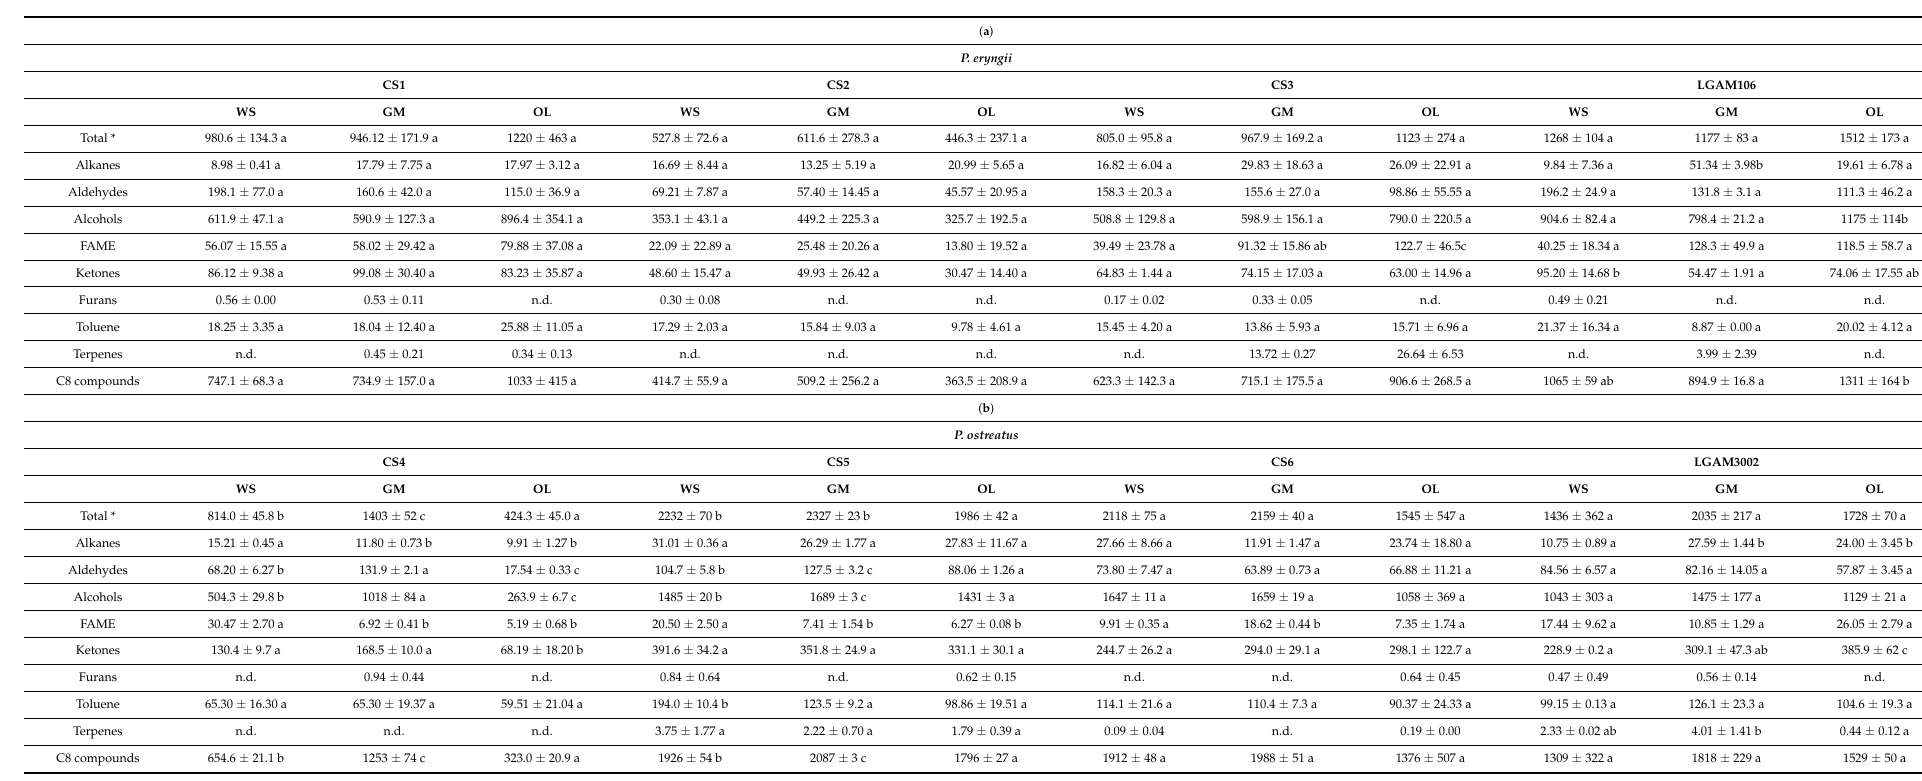
Table 2. ( a ) Classes of volatiles and toluene ( µ g/g f.w. equivalents of 4-methyl-2-pentanol) in P. eryngii (strains CS1, CS2, CS3 and LGAM106) mushrooms grown on different cultivation substrates (WS, GM and OL). ( b ) Classes of volatiles and toluene ( µ g/g f.w. equivalents of 4-methyl-2-pentanol) in P. ostreatus (strains CS4, CS5, CS6 and LGAM3002) mushrooms grown on different cultivation substrates (WS, GM and